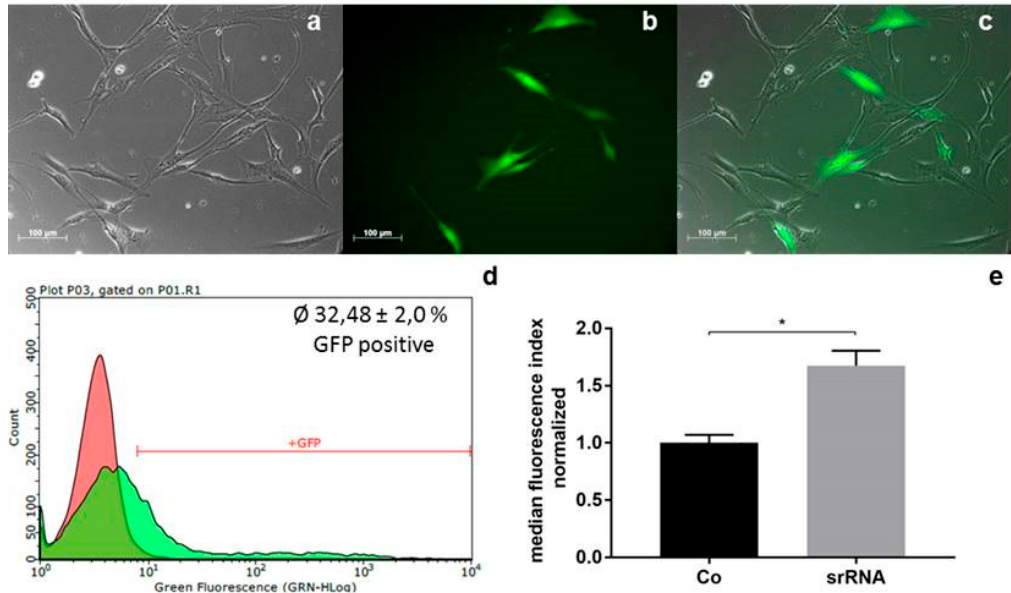
Figure 1. Transfection of jaw periosteal cells (JPCs) with self-replicating RNA (srRNA). ( a – c ) Representative ( a ) brightfield, ( b ) green fluorescent protein (GFP), and ( c ) merged images of JPCs 24 h after srRNA transfection. ( d ) Representative histogram of flow cytometry measurements of untransfected (red) and srRNA transfected (green) JPCs 24 h after transfection. ( e ) Average normalized median fluorescence index (MFI) values + standard deviation (SD) of srRNA transfected and untransfected (Co) JPCs relative to MFI values of untransfected (Co) samples were calculated and compared using Student’s t -test ( n = 3, * p < 0.05).